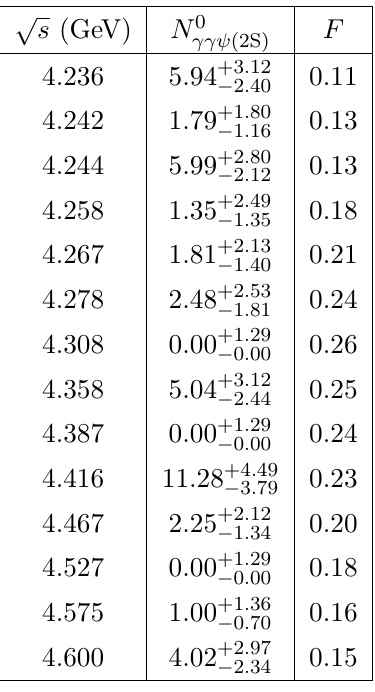
Table 2. The number of e + e − → γγψ (2 S ) events outside the η signal region [ N 0 F factor at each c.m.